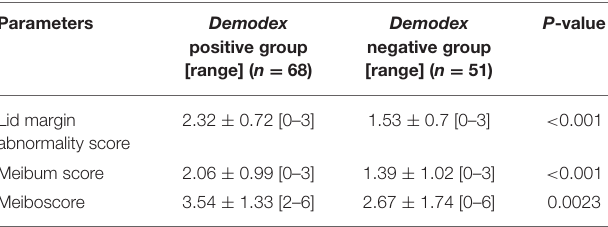
TABLE 2 | Meibomian Gland Function Indices in Demodex positive and Demodex negative